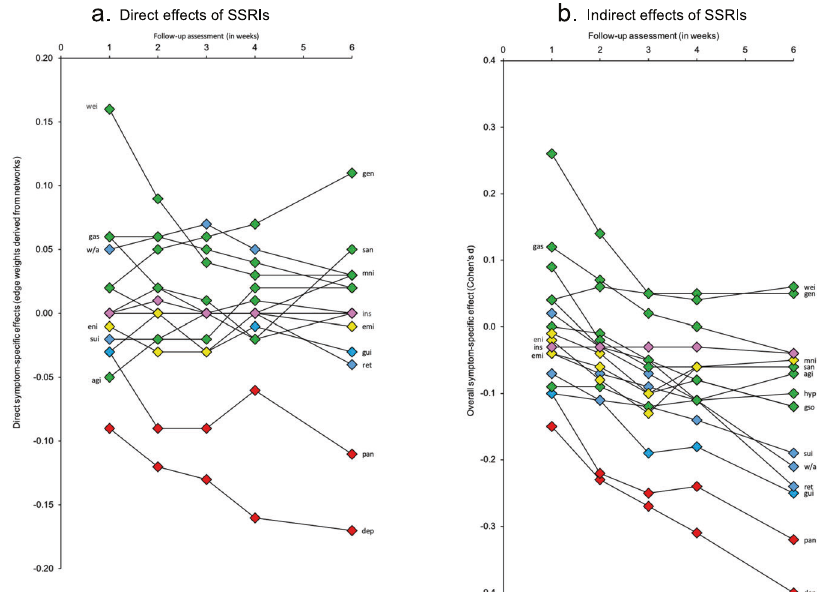
Fig. 2 The development of symptom-speci fi c effects of SSRIs during six weeks of treatment. a Direct effects of SSRIs. b Overall effects of